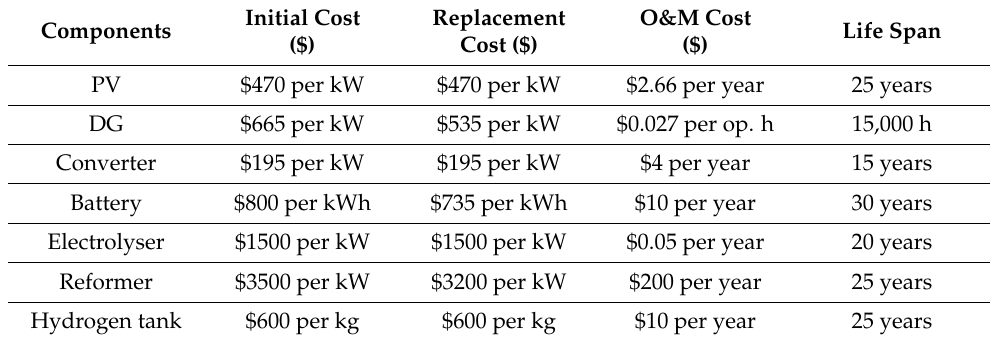
Table 4. Financial metrics of HEGS